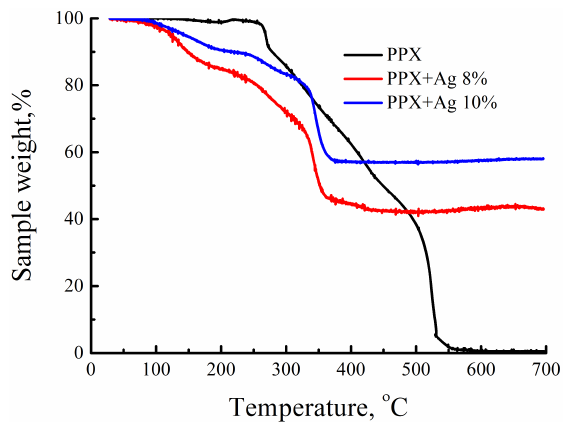
Figure 2. The thermogravimetric measurements of PPX+Ag coatings with different concentrations of silver in air